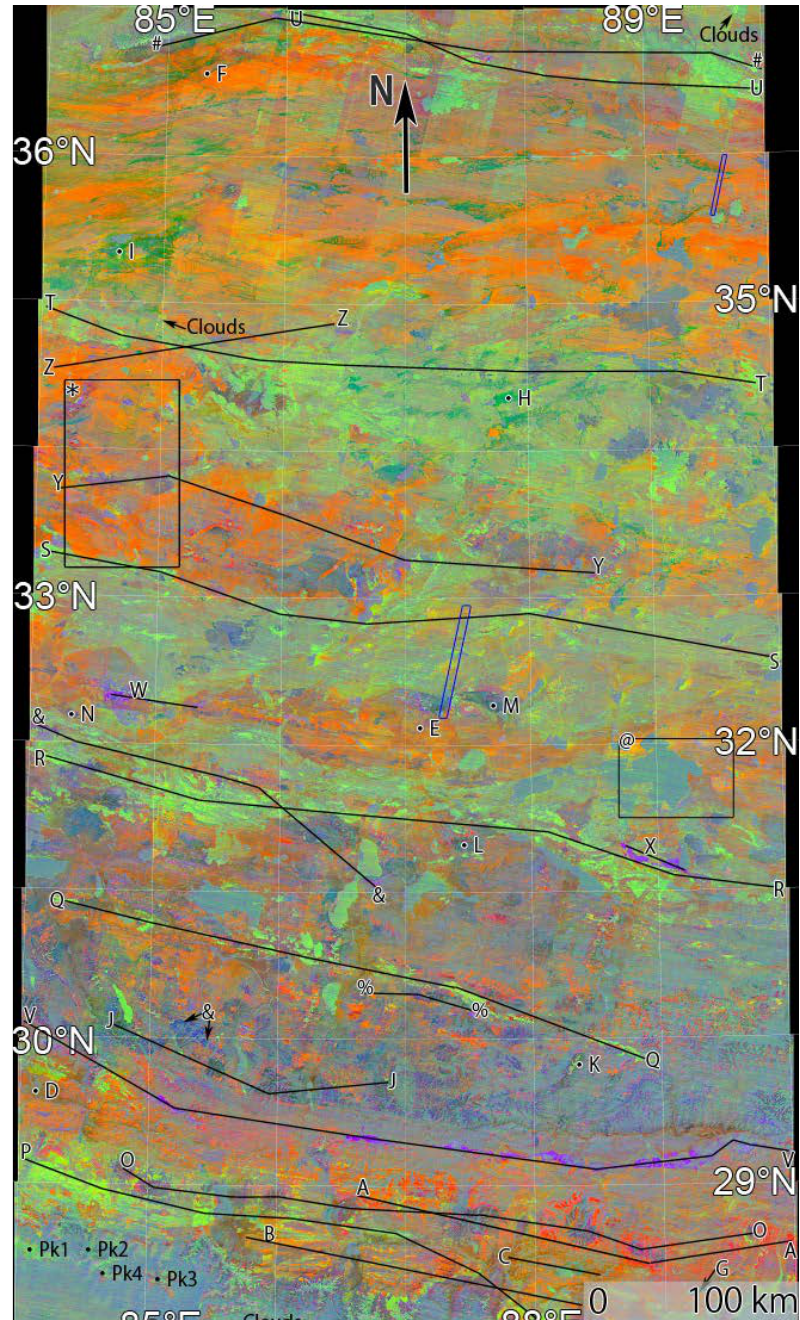
Figure 4. Mosaic color composite image of QI, CI and MI with a linear contrast stretch of 0.97–1.055 (QI; Red), 1.005–1.055 (CI; Green) and 0.79–0.95 (MI; Blue), with ASTER Level-3A products. The areas bounded by the blue polygons were mapped with Level-1B products when Level-3A products were not available. The annotations indicate the locations discussed in the text. The extent of the study area and the map projection are described in the caption in Figure 2.